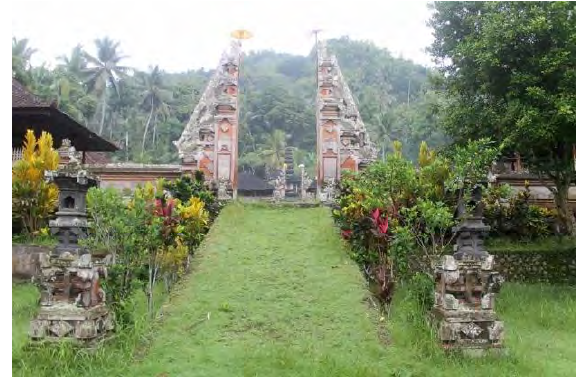
Figure 8. A typical village pura in Selumbung village, eastern Bali (Courtesy of Selumbung.com)